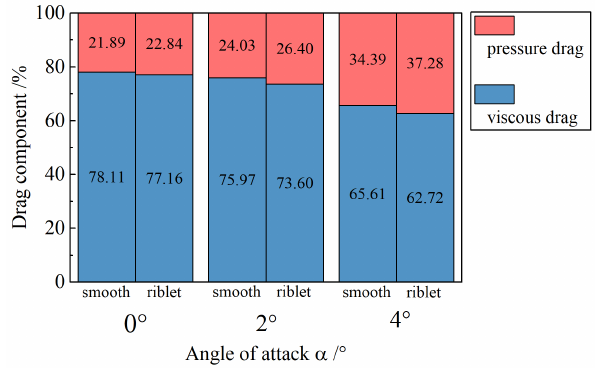
Figure 22. The proportions of pressure drag and viscous